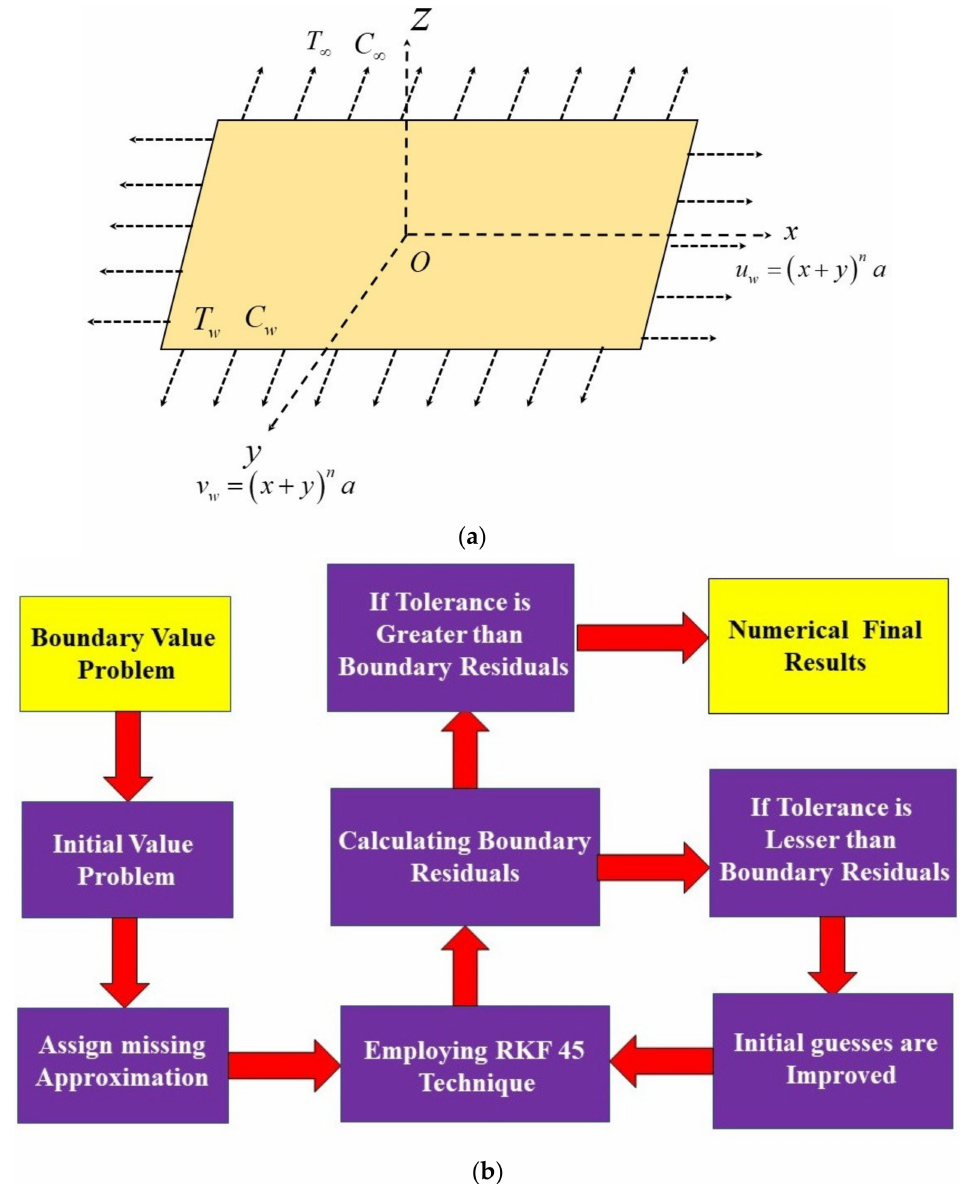
Figure 1. ( a ): Physical representation and coordinate system. ( b ) Flow chart for numerical